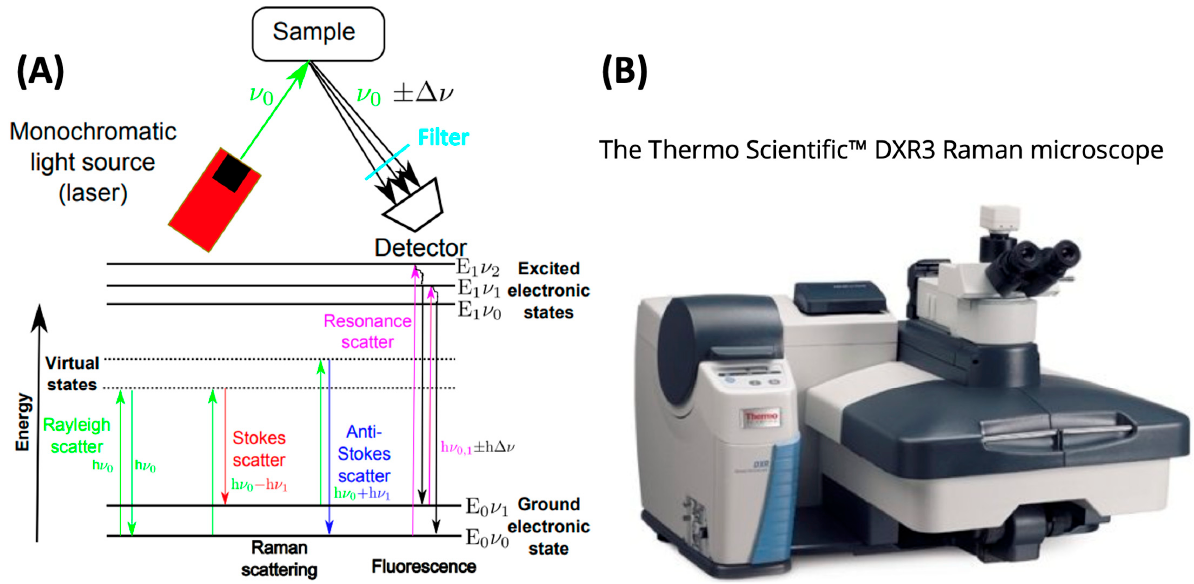
Figure 6. ( A ) Schematic of the fundamental principles of Raman spectroscopy, highlighting the main scattering and fluorescence excitations of a sample after it is excited using a monochromatic light source of frequency equal to ν 0 . The Raman stokes line experiences a frequency shift of D ν that corresponds to the difference between vibrational energy levels. ( B ) A benchtop, commercially available Raman microscope. ( A ) from Ref. [67] via Creative Commons license and ( B ) from Thermo Fisher Scientific.